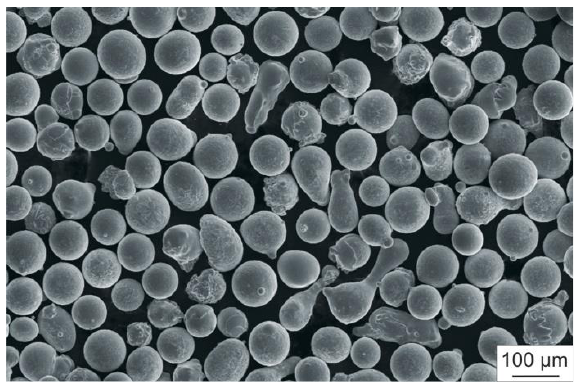
Figure 1. SEM of NiAl powder used as a cladding material.